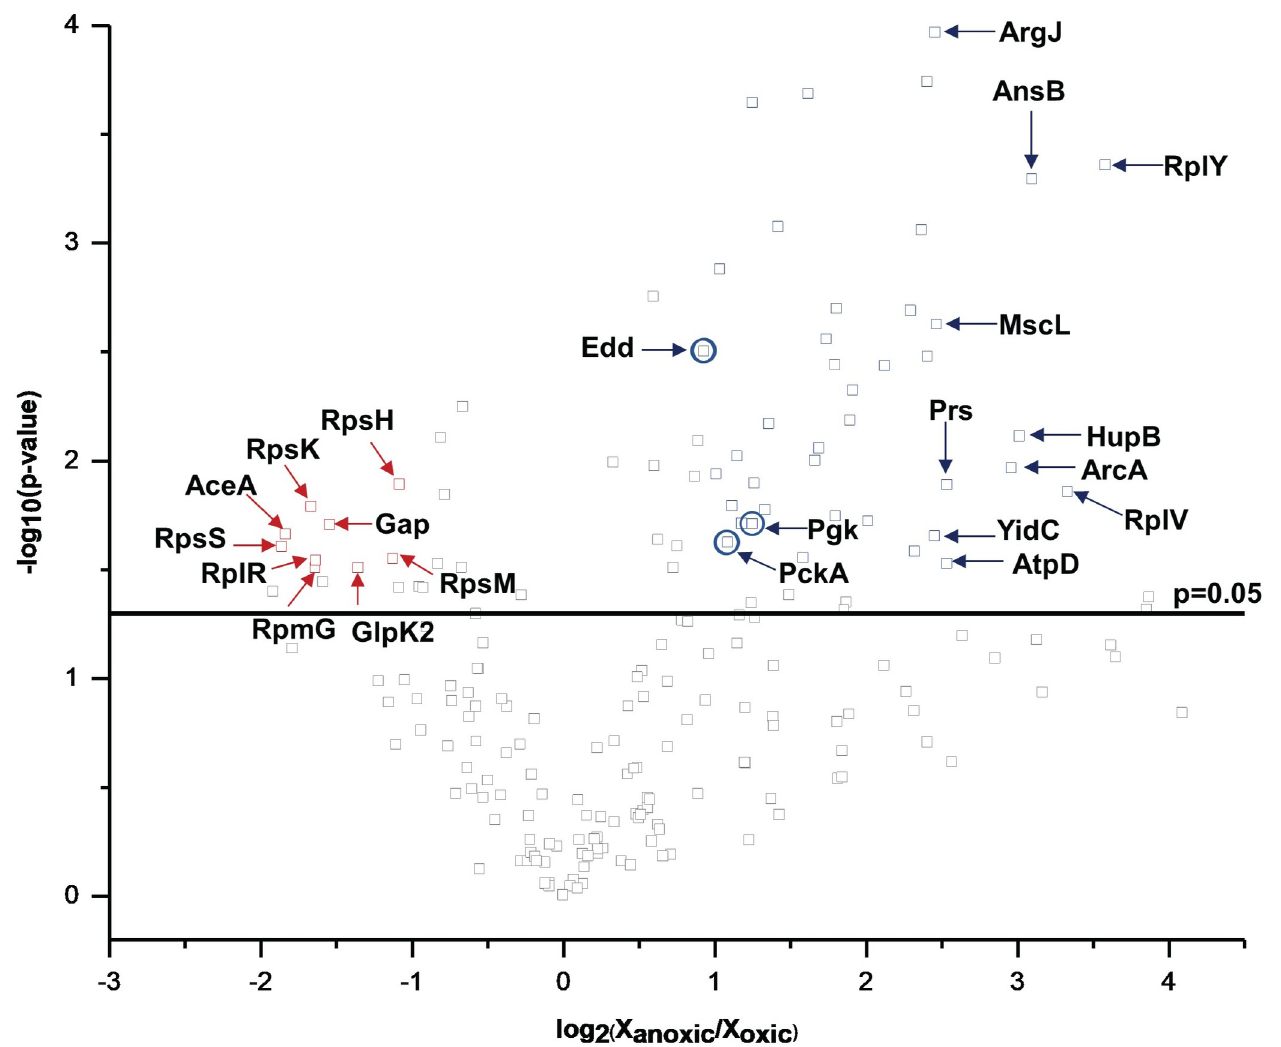
Fig 6. Volcano plot of statistically significant, differentially expressed proteins from transwell-membrane biofilms. Differential protein abundances for anoxic vs. oxic regions of P . aeruginosa three day grown transwell biofilms. Proteins with statistically significant (-log 10 (p-value) > 1.3) changes in abundance are highlighted above horizontal black line. Of those, proteins with |log 2 (X anoxic /X oxic )| � 1, where X (an)oxic is protein abundance, are deemed as significantly higher or lower abundances and are annotated as blue or red points, respectively. The ten proteins that displayed the greatest fold changes in abundance are labelled with their three or four-letter protein codes (S2 Table in S1 File). Glucose catabolizing proteins that display significant changes in abundance are also circled (Edd, Pgk, and PckA).